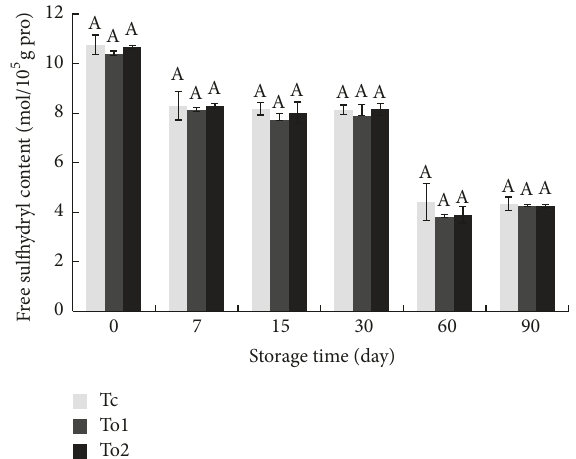
Figure 1: Changes in free sulfhydryl content of myofibrillar proteins extracted from silver carp surimi during frozen storage. Light grey: two washing cycles using ice water only (Tc), dark grey: first and second washing cycle using ice water containing 8 mg/L ozone and ice water, respectively (To1); black: first and second washing cycle using ice water and ice water containing 8 mg/L ozone, respectively (To2).Differentlettersindicatesignificantdifferenceamongsamples (Tc, To1, and